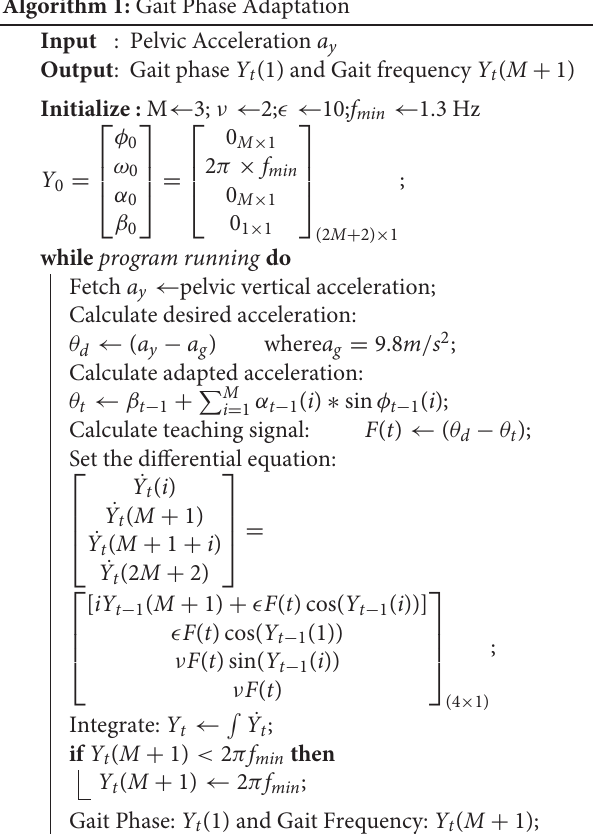
Algorithm 1 along with the knowledge of HS events of a leg